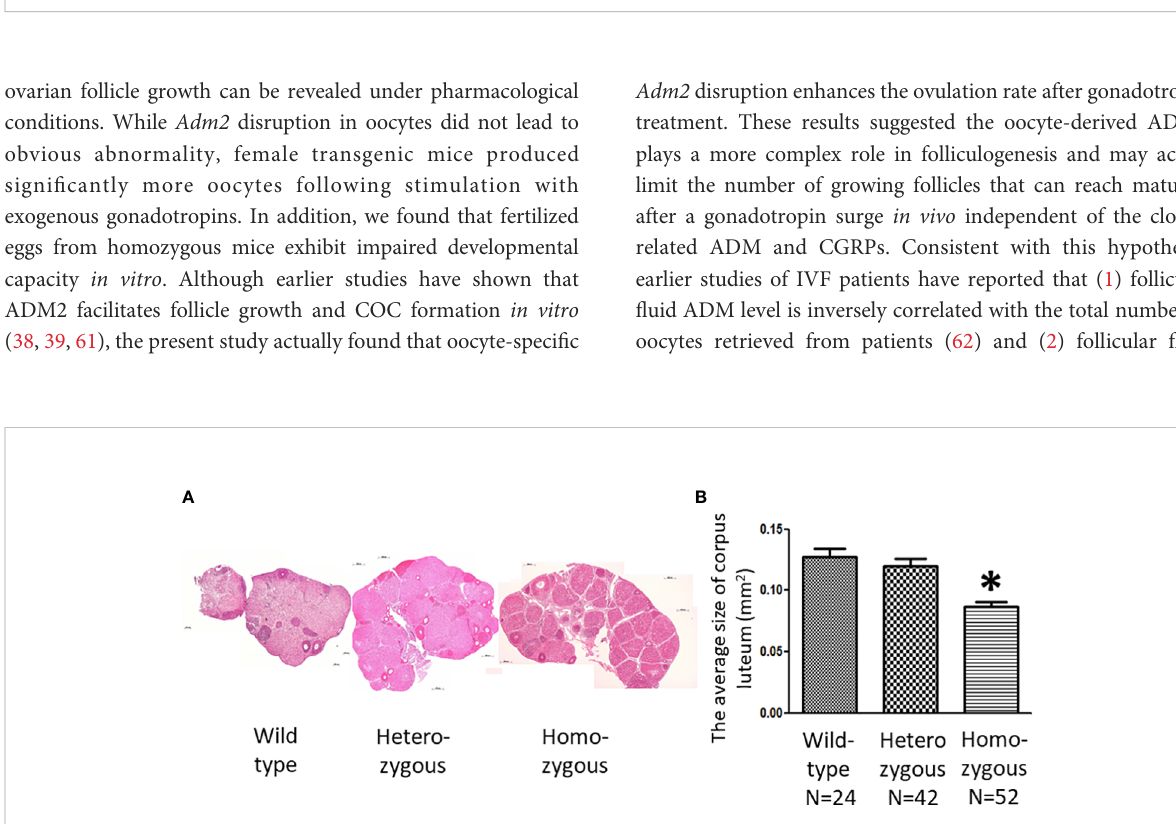
FIGURE 6 Effects of oocyte-speci fi c Adm2 disruption on corpus luteum following synchronized ovulation. (A) Histological sections of representative ovaries following superovulation. All ovaries contained a large number of corpus luteum, and the relative size is indicated by the horizontal scale bars. (B) The average size of corpus luteum of wild-type ( Adm2 +/+ /Zp3 -Cre), heterozygous ( Adm2 +/- / Zp3 -Cre), and homozygous ( Adm2 -/- / Zp3 - Cre) mice following superovulation (mean ± SEM). The size of the corpus luteum was individually determined by the HistoQuest and Image J software. The average size (mm 2 ) of all corpora lutea within two representative sections of an ovary is represented by vertical bars. *, signi fi cantly different from the wild-type group at p < 0.01.